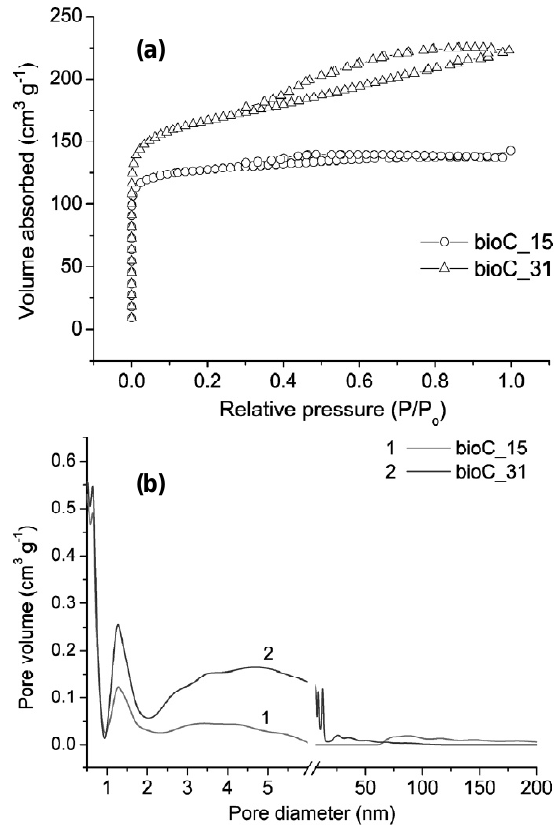
Fig. 3. (a) N adsorption/desorption isotherms and 2 (b) pore size distribution curves for monolithic acti- vated biocarbons bioC_15 and